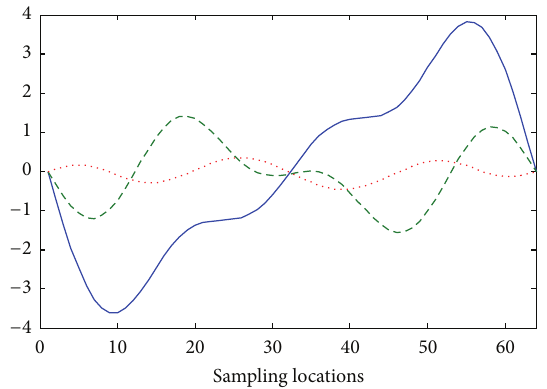
Figure 1: The first 3 initial